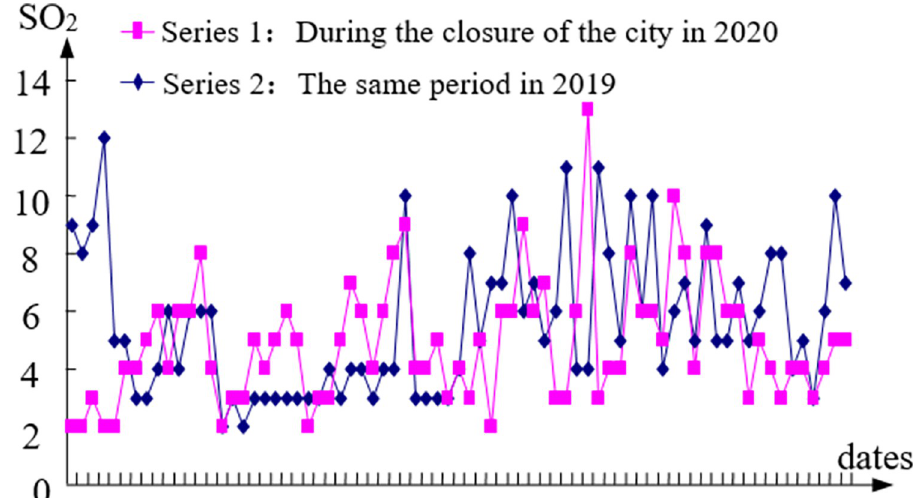
Fig 10. The comparison of SO 2